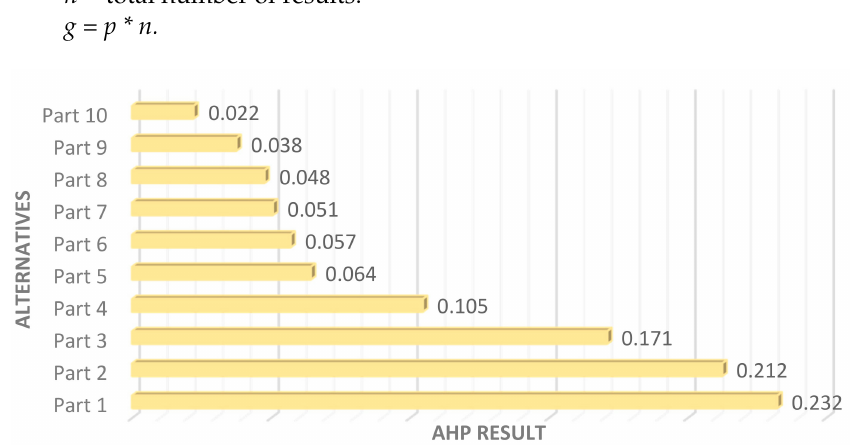
Figure 6. Example of the AHP result of a manager. Table 5. Comparative results for each AHP.